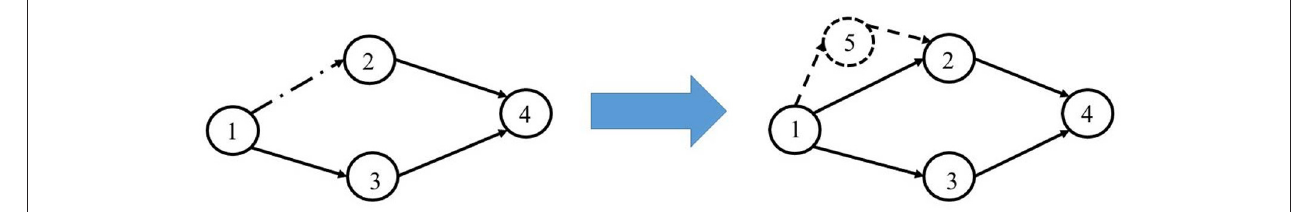
FIGURE 1 | Revision of transportation network with AV dedicated